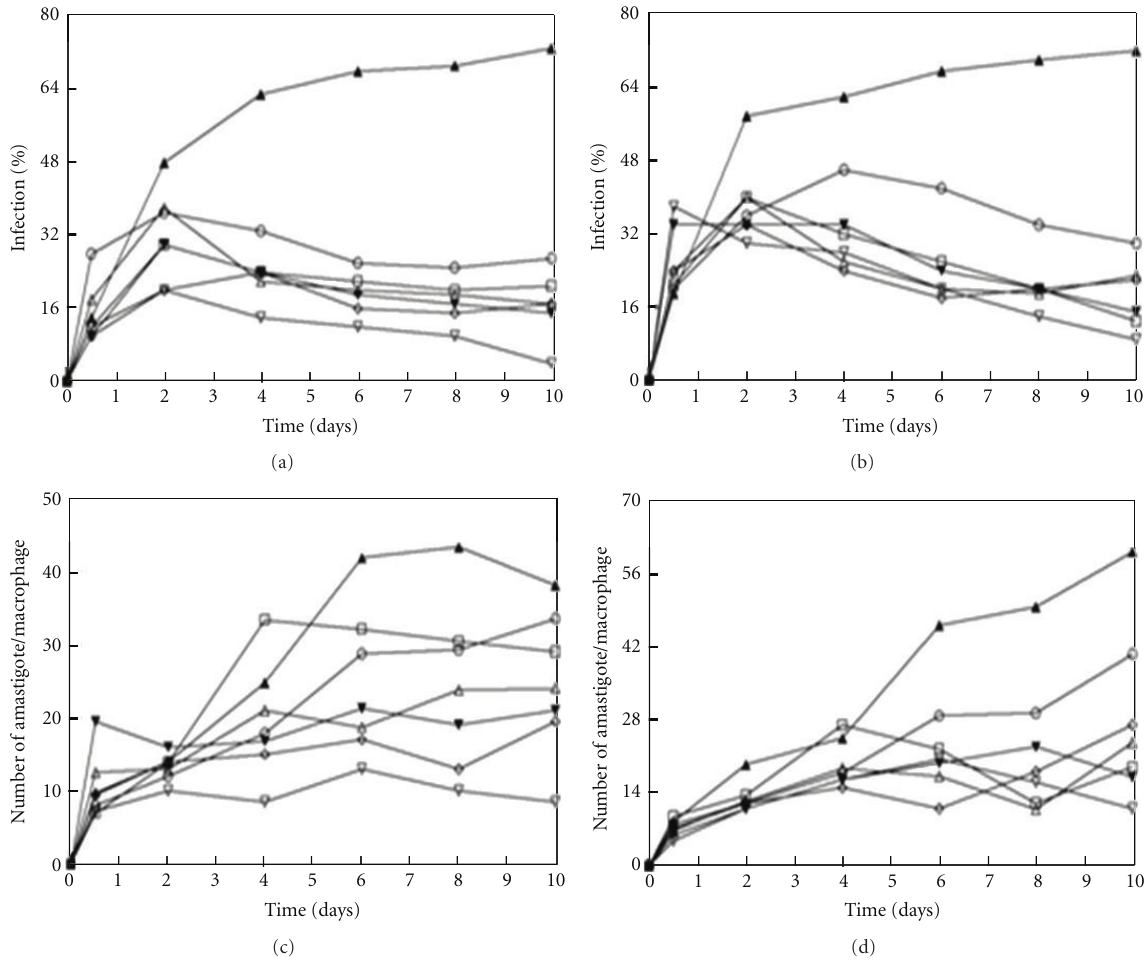
Figure 2: E ff ects of flavonoids 4 , 5 , 6 , 7 , and 8 on the infection and growth rates of Leishmania spp. (a) rate of infection of L. infantum ; (c) mean number of amastigotes per infected J774 A.2 macrophage cells of L. infantum ; (b) rate of infection of L. braziliensis ; (d) mean number of amastigotes per infected J774 A.2 macrophage cells of L. braziliensis . (- (cid:2) -, control; - (cid:3) -, comp. 4 ; - (cid:4) -, comp. 5 ; - (cid:5) -, comp. 6 ; - ♦ -, comp. 7 ; - ∇ -, comp. 8 ; - (cid:5) -, Glucantime). At IC 25 conc., values are means of three separate